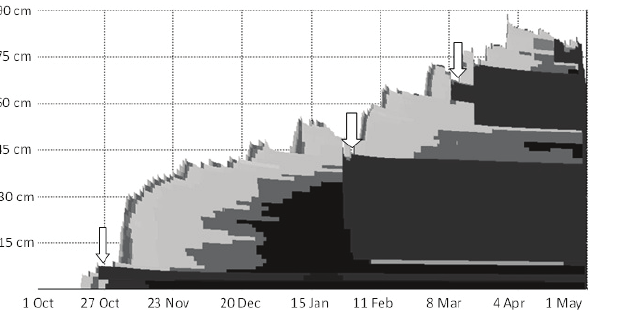
Figure 8. Evolution of the snow structure during win- ter 1991/1992 according to the simulations made by the SNOWPACK model. Shadowed areas separate the lay- ers with different snow structure. Areas with light gray shading indicate dry snow with grains recently bonded together, and dark shaded areas closer to the bottom of the snow cover represent layers with loosely bonded, porous depth hoar. Occasions with melt and subsequent refreeze of snow (formation of icy layers or ground ice) are marked with white arrows. Icy layers formed dur- ing the early or mid-winter are possible to distinguish throughout the winter until the snow